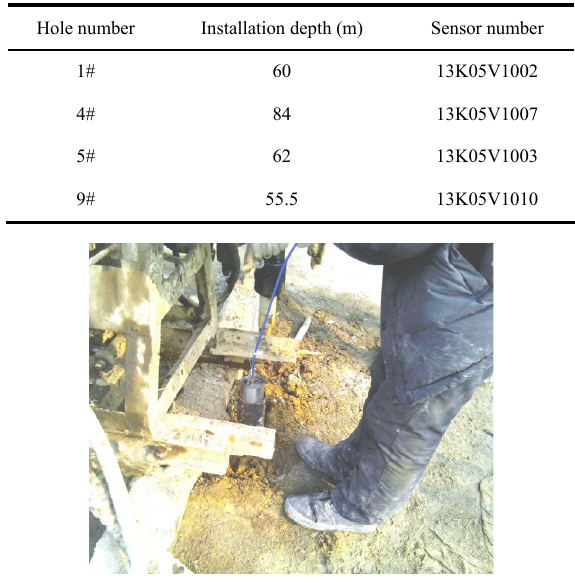
Fig. 9 Field installation of micro-seismic